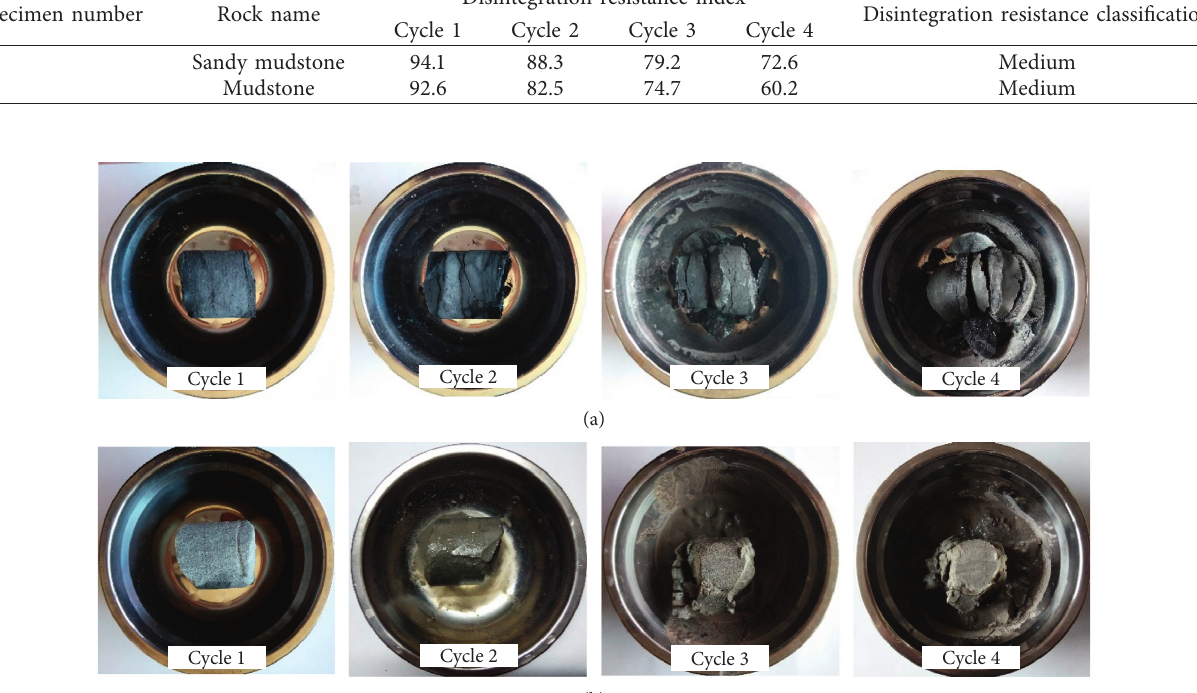
Figure 2: Disintegration resistance test of rock samples. (a) Disintegration process of mudstone and (b) disintegration process of sandy mudstone.